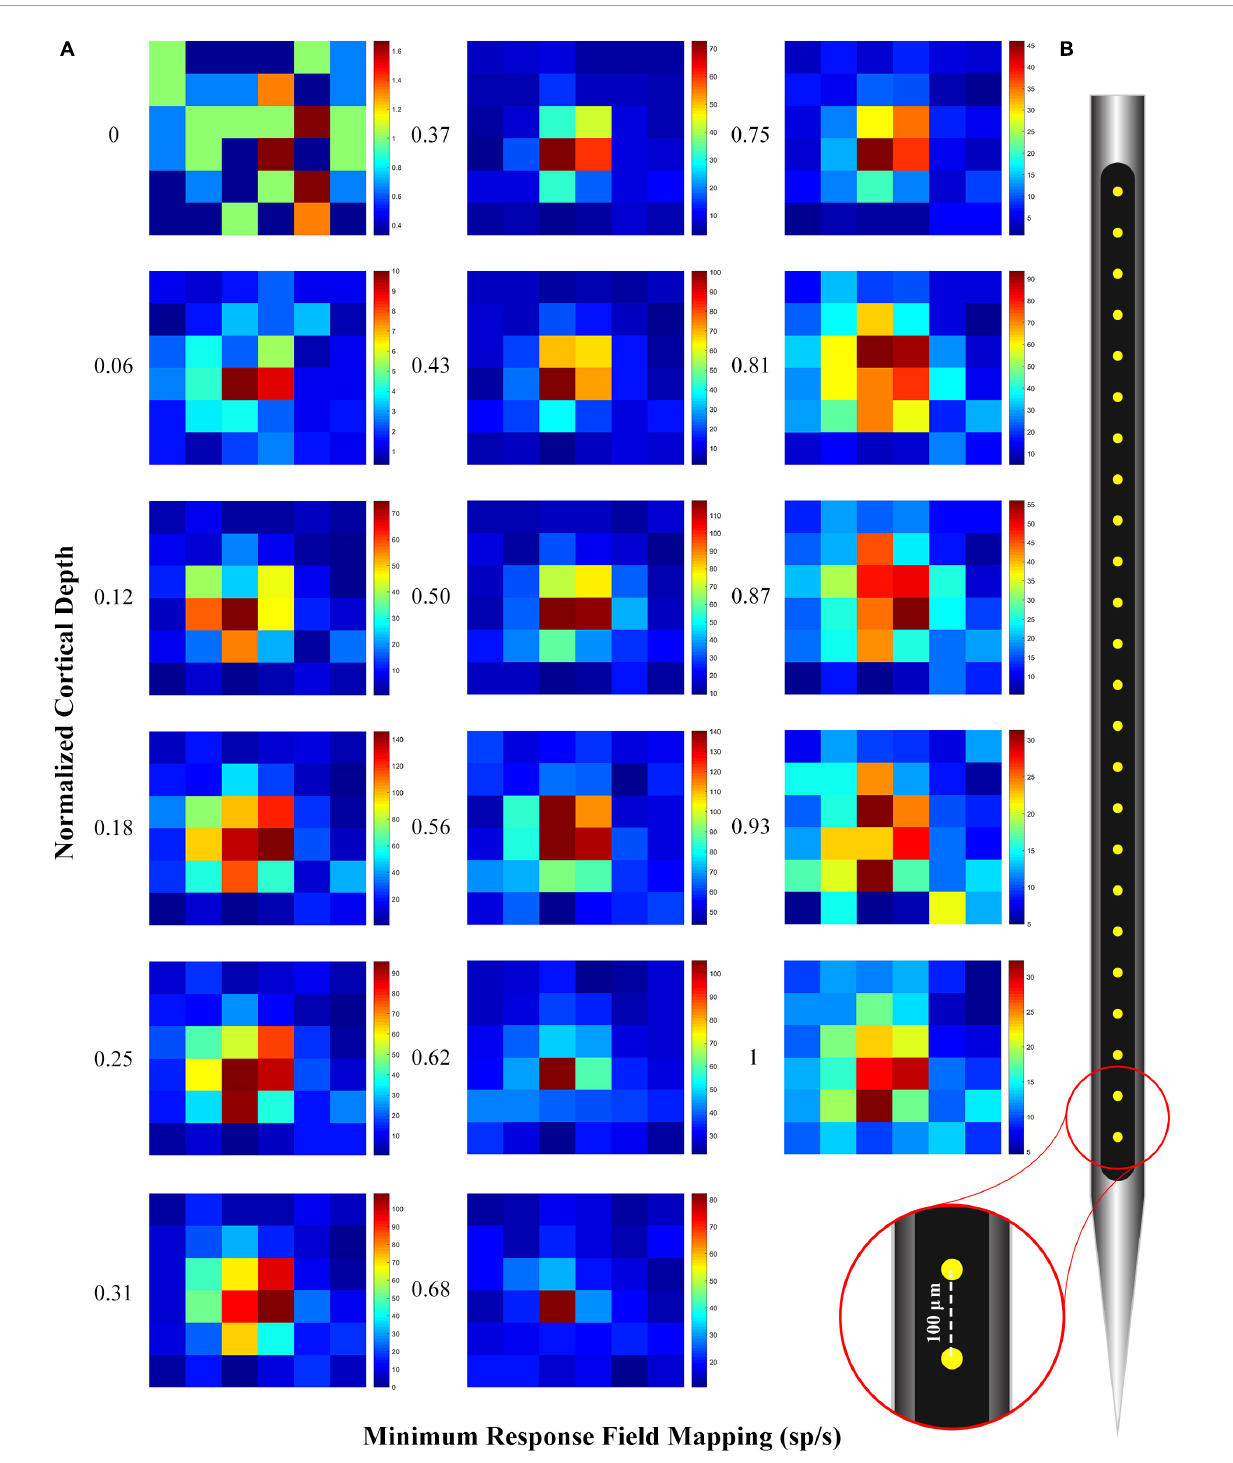
FIGURE2 (A) Receptive field (RF) mapping plot with spike per second in normalized cortical depth. The heatmap was obtained from the average of multiunit activity (MUA) in response to the 0.5 degree black square stimulus that was randomly presented in all 36 squares (Each square shown in the figure is 0.5 degrees). A good alignment of the RF mapping across the contact points indicates that the electrode is perpendicular. (B) 24-channel linear electrode arrays (100 µ m inter-contact spacing, 20 µ m contact diameter; V-Probe, Plexon, Texas).